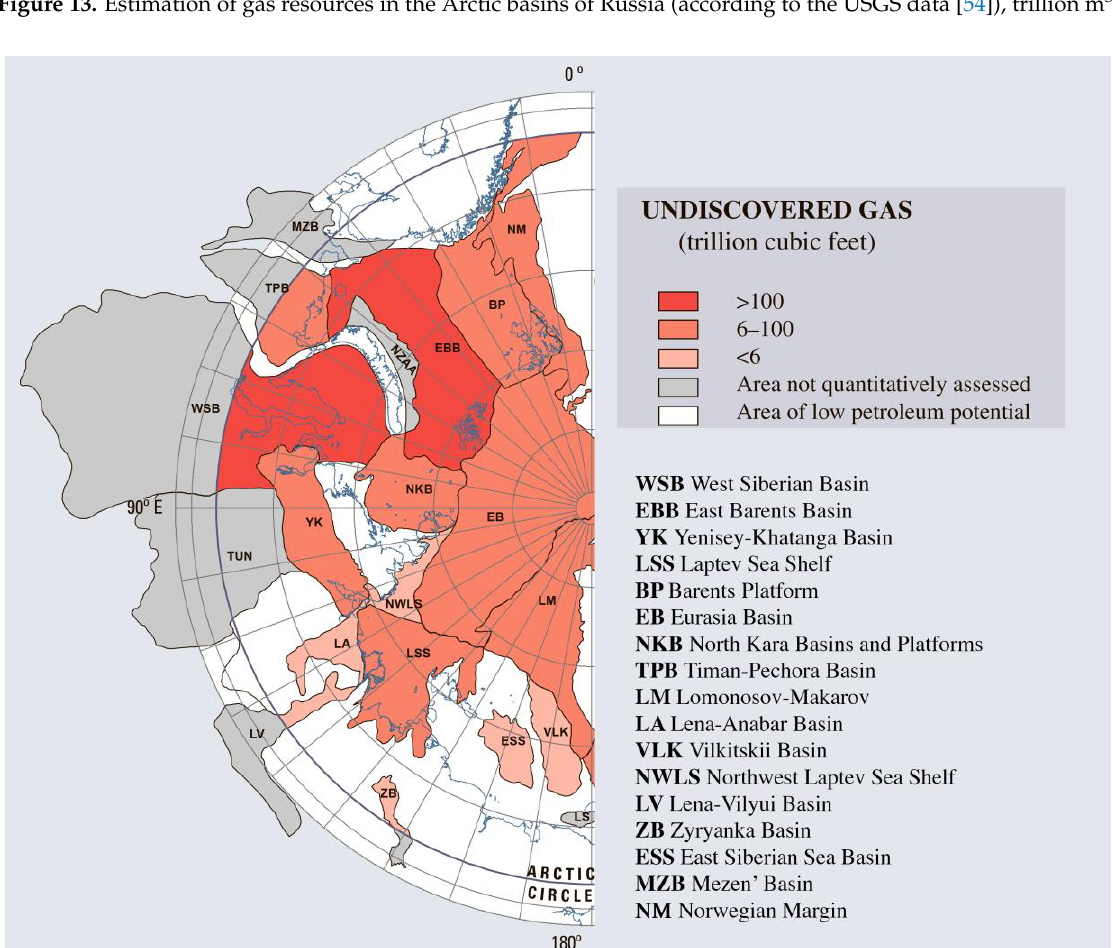
Figure 13. Estimation of gas resources in the Arctic basins of Russia (according to the USGS data [54]), trillion m 3 .